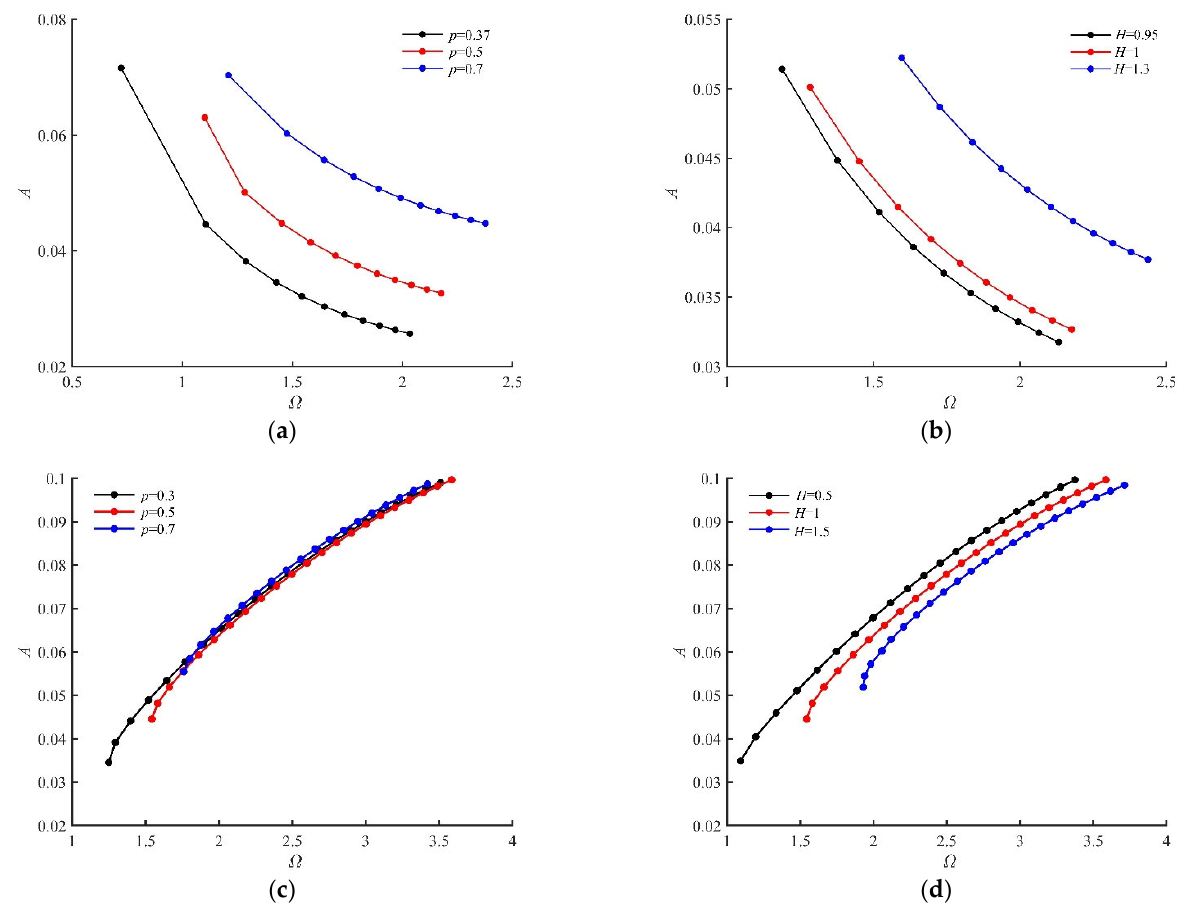
Figure 9. The results of transition set with α = 0.89; ( a ) the hysteresis set with p = 0.37, 0.5, 0.7 and H = 1; ( b ) the hysteresis set of Equation (20) with H = 0.95, 1, 1.3 and p = 0.5; ( c ) the bifurcation set with p = 0.3, 0.5, 0.7 and H = 1; ( d ) the bifurcation set with H = 0.5, 1, 1.5 and p =